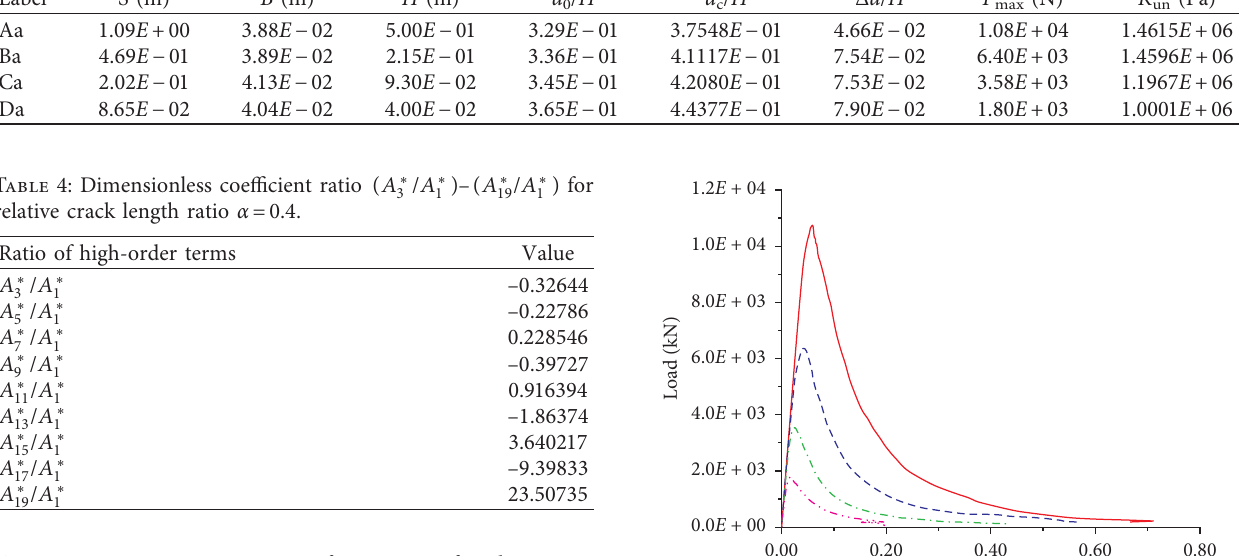
Table 3: Results calculated from the double-K model.